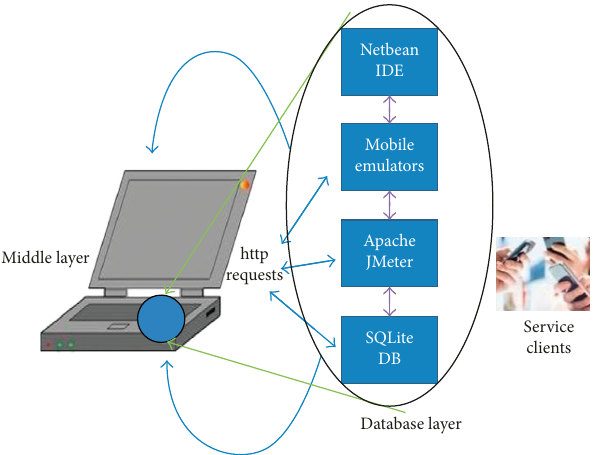
Figure 4: Mechanism simulation